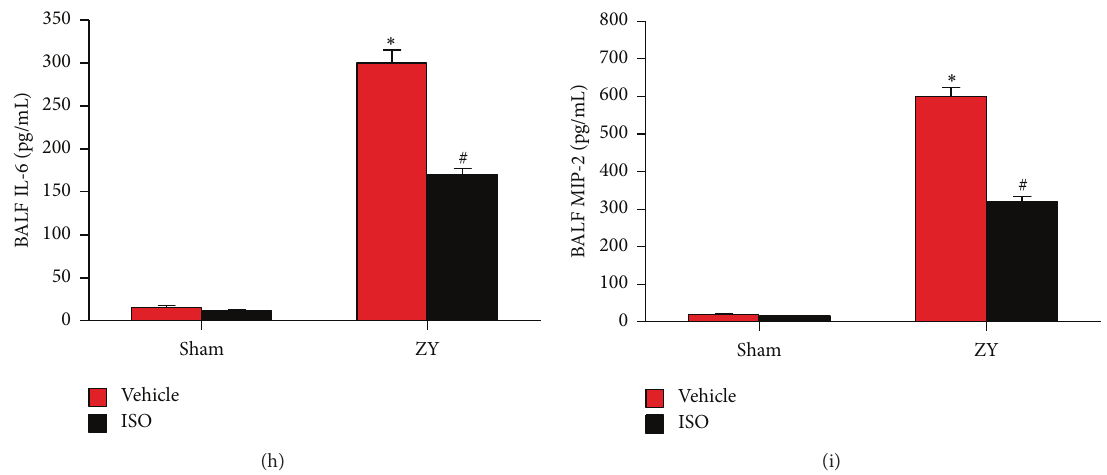
Figure 4: Treatment with 1.4% ISO downregulates proinflammatory cytokine levels in lung tissues and BALF from ZY-challenged mice. (a) RT-PCR analysis for the expression of TNF- 𝛼 , IL-1 𝛽 , IL-6, and MIP-2 mRNA; (b)–(e) amplicons were densitometrically quantified, and bars represent the relative amounts of amplified TNF- 𝛼 , IL-1 𝛽 , IL-6, and MIP-2 mRNA normalized against 𝛽 -actin; (f) BALF TNF- 𝛼 ; (g) BALF IL-1 𝛽 ; (h) BALF IL-6; (i) BALF MIP-2. BALF was obtained to measure these indicators using ELISA kits. The respective densitometric analysis of mRNA bands is from three separate experiments. The animals were treated as described in Figure 1. Data are mean ± SD ( 𝑛 = 10 mice per group). ∗ 𝑃 < 0.05 versus sham; # 𝑃 < 0.05 versus ZY +